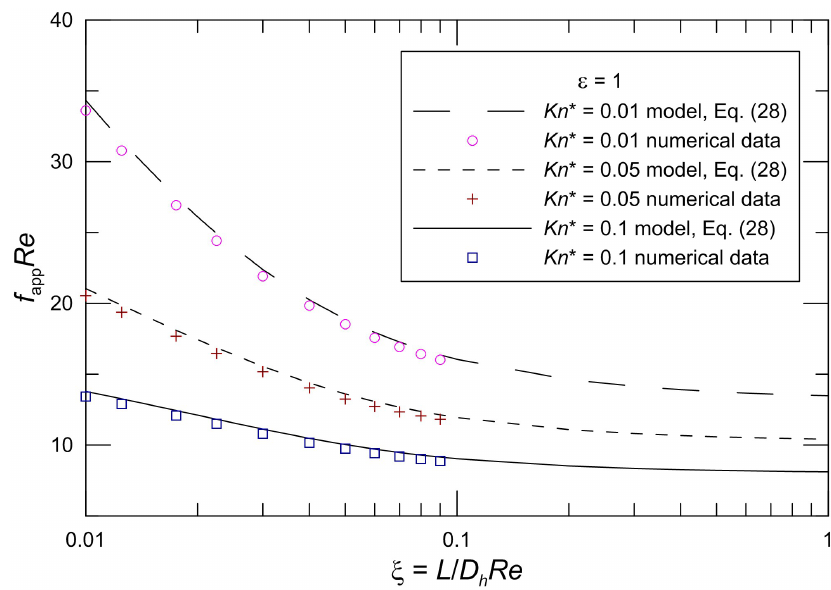
Figure 6 . Comparison of f app Re for our numerical data.